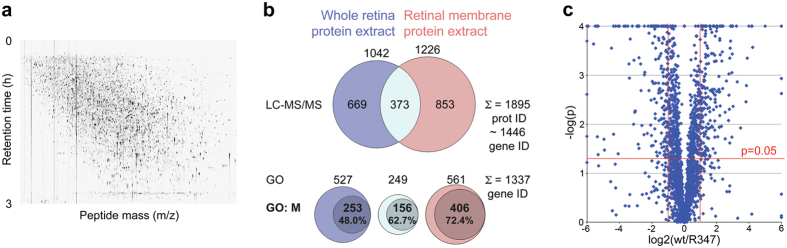
LC-MS/MS retinal proteome analysis in R347 versus wt mice.Whole retina protein (n = 4) and retinal membrane protein (n = 4) extracts were prepared from one month-old R347 and wt mice. LC-MS/MS analysis was performed on an Ultimate3000 nano HPLC system coupled to a LTQ OrbitrapXL mass spectrometer. (a) Representative LC-MS/MS profile detected in the retinal samples. (b) Distribution of the 1895 identified protein IDs, which were mapped to 1446 gene IDs. 1337 gene IDs were present in the GO database (GO); GO: M refers to entries with membrane in their GO search terms. (c) Volcano plot representation of the identified protein IDs in R347 versus wt retinas. X-axis indicates difference in expression level on a log2 scale, whereas the y-axis represents corresponding p-values (Student’s t-Test) on a negative log scale. Red lines indicate 0.5-fold and 2-fold differences in protein expression and significance level of p = 0.05, respectively. Scaling was limited to -6 and 6 on the horizontal axis and 4 on the vertical axis. Entries outside the limiting values were set to the corresponding limiting values.